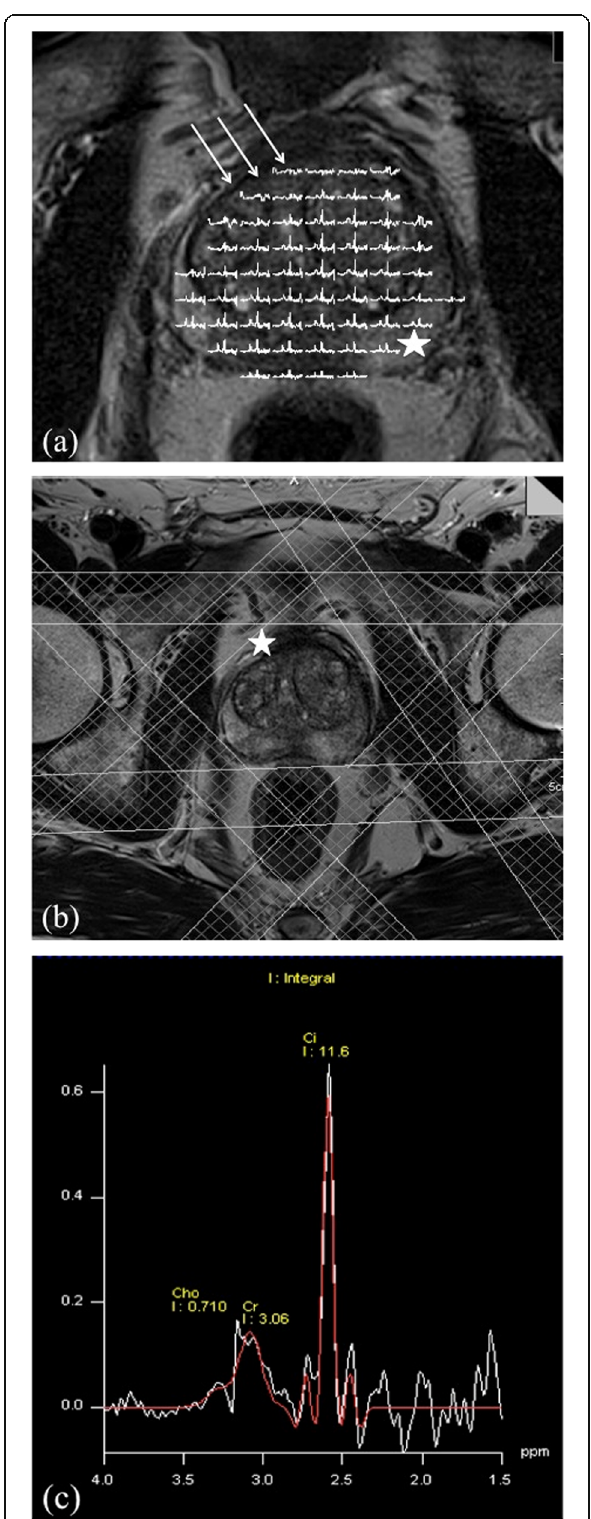
Fig. 1 Prostate spectroscopy with conventional planning of saturation pulses, acquisition matrix, and field of view. Small posterolateral parts of the prostatic gland were not included ( a white star) and low quality of several spectroscopic voxels in the right anterior region of the prostatic gland ( a : white arrows). This may be due to imprecise positioning of saturation pulses ( b , white star: Saturation pulse is not exactly aligned to the margin of the prostatic gland). Sample spectrum of the mid-peripheral zone showing acceptable diagnostic quality ( c